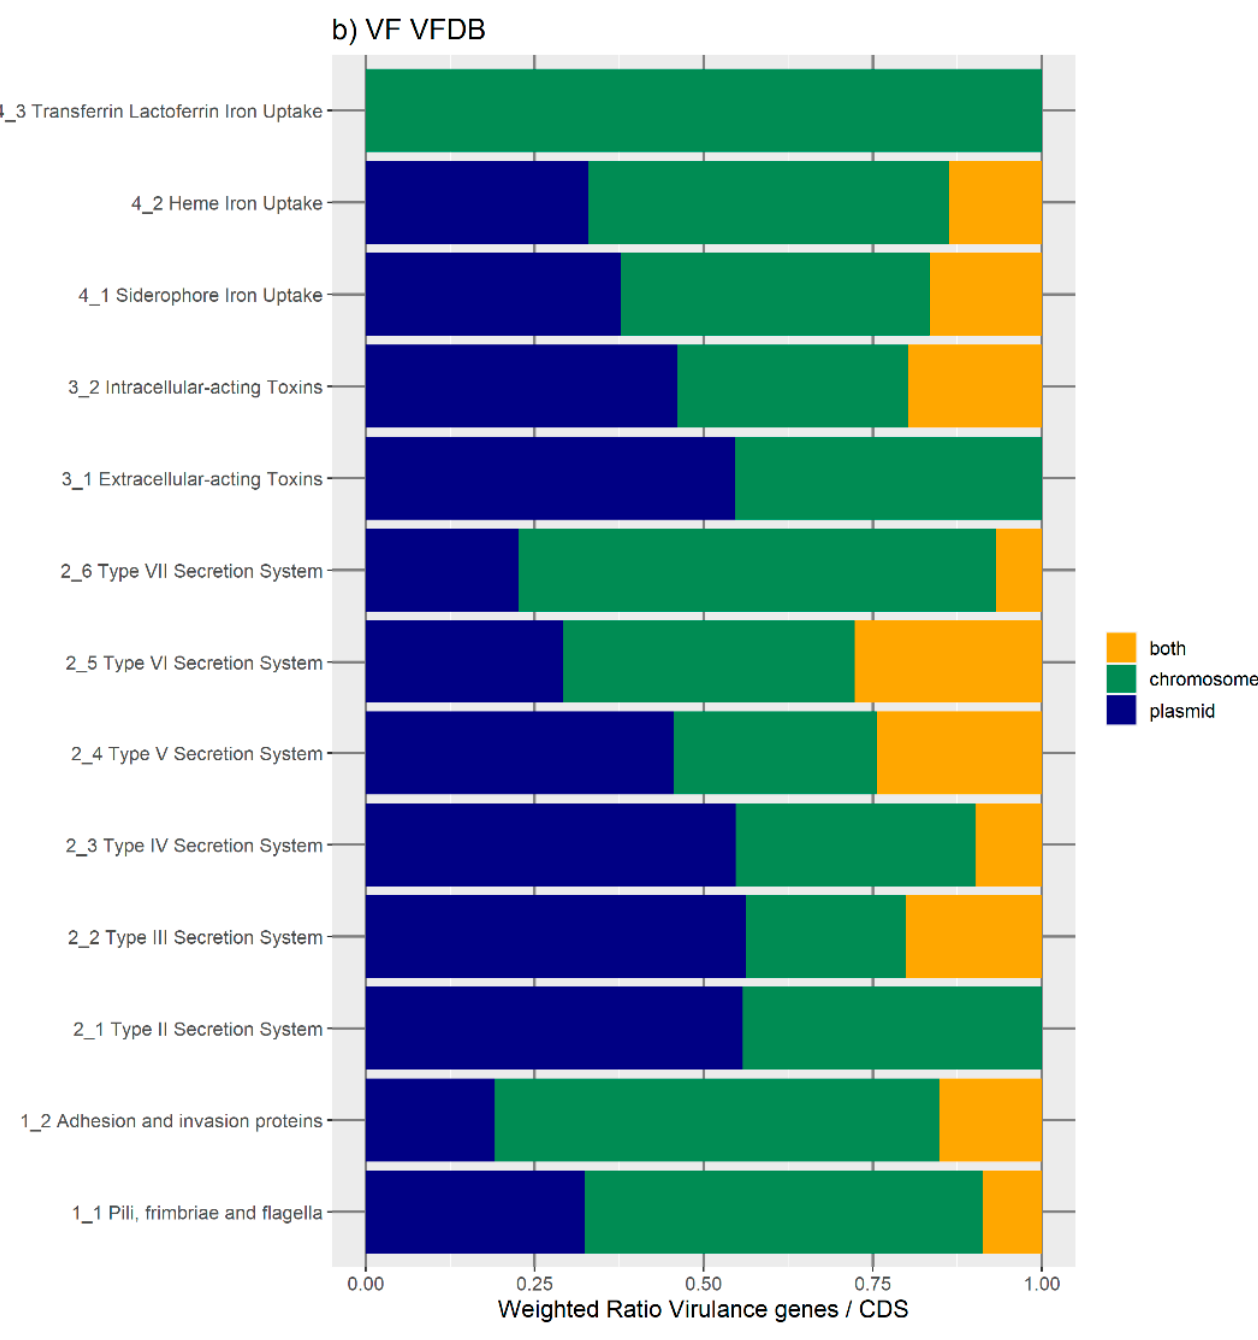
Figure 3. Bar plots ( a ) and weighted bar plots ( b ) of the number virulence factor orthologues in VFDB. Because replicons vary in size, the number of virulence orthologues in each genome was divided by the amount of coding DNA sequences (CDS) in that genome (in that plasmid, in that chromosome, or in both). ( a ) There is a higher number of virulence factor orthologues located in chromosomes (green) than only in a plasmid or in both a plasmid and the chromosome. There is a higher number of orthologues of Pili, fimbriae, and flagella and type III secretion systems than orthologues of the other virulence genes. ( b ) Orthologues of virulence genes are proportionally more present in the chromosome (green) only or in a plasmid only (blue). Transferrin and lactoferrin iron uptake orthologues are only located in chromosomes (green). Extracellular acting toxins and type III secretion system orthologues were either located in a plasmid (blue) or in the chromosome (green), not in both (yellow).